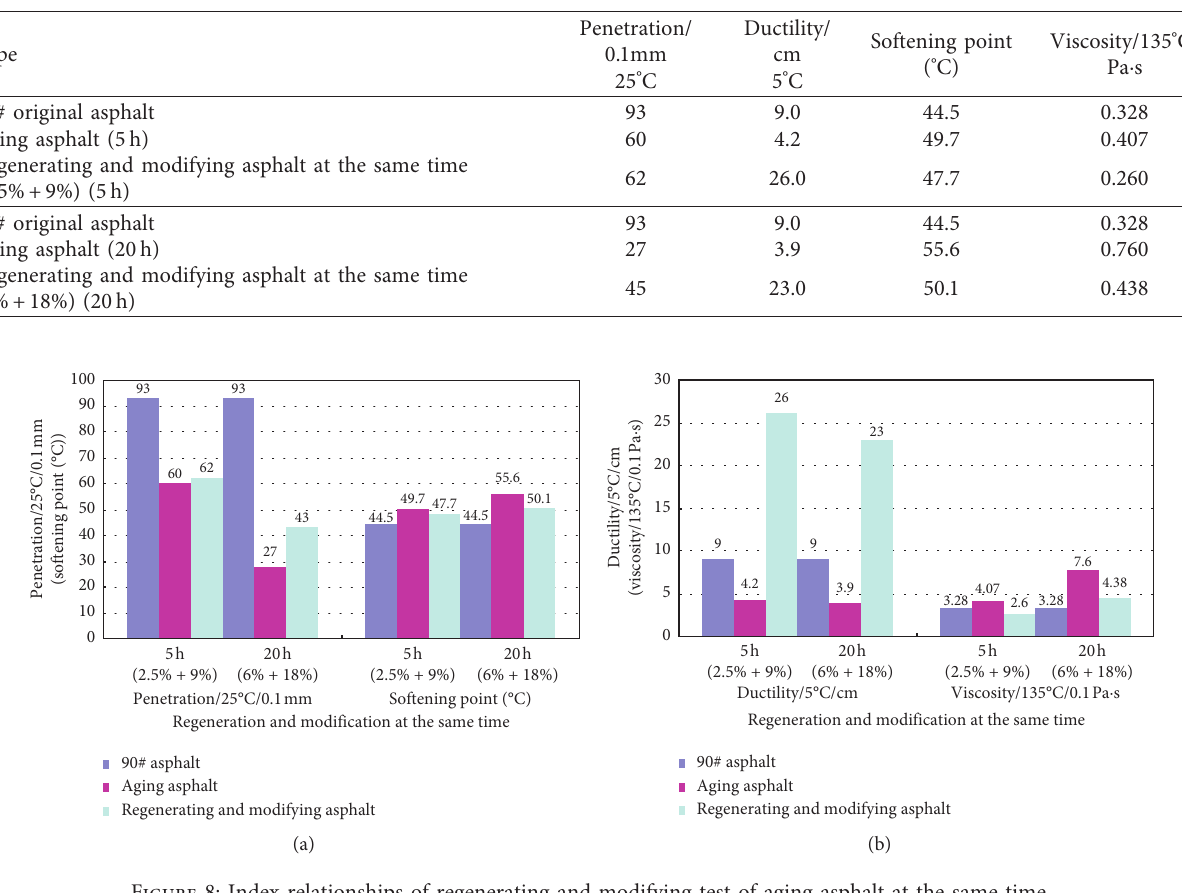
Table 11: Indexes of regenerating and modifying test of aging asphalt at the same time.